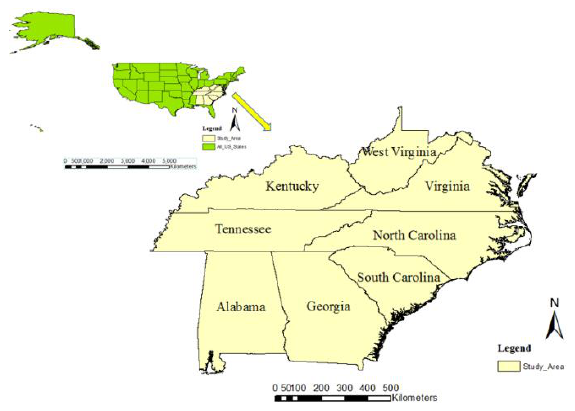
Figure 1.Study area